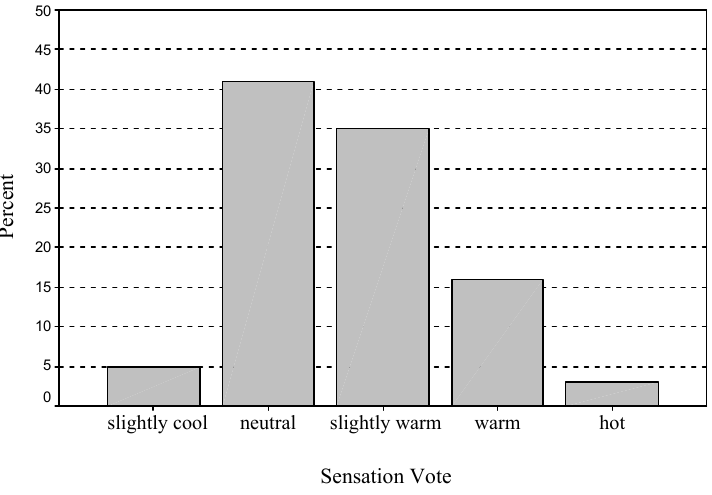
Figure 7. Southern Europe atrium sensation votes in the warm season.